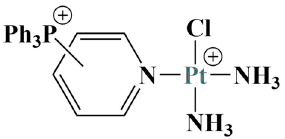
Figure 1. Modified pyriplatin, described in